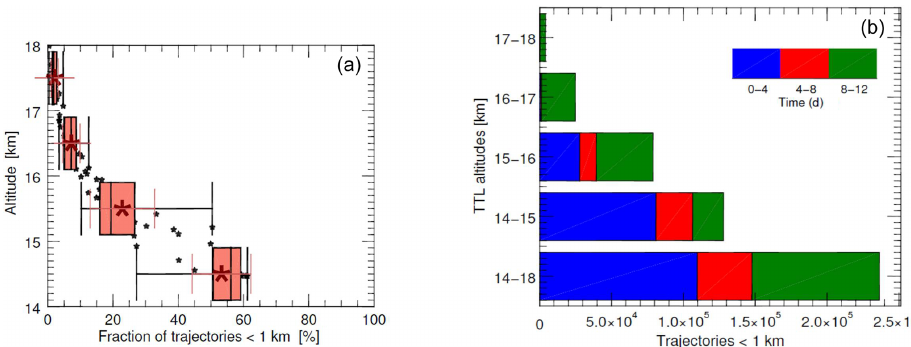
Figure 2. Vertical distribution of NAME 1km fractions (the fractions that reach the boundary layer within 12d – indicative of boundary layer air influence) in the TTL (a) . Distribution of transport times taken for the trajectories to first cross below 1km (reach the boundary layer) for all the NAME runs and the NAME runs grouped into 1km TTL segments, research flight 02, ATTREX 2014 (b)